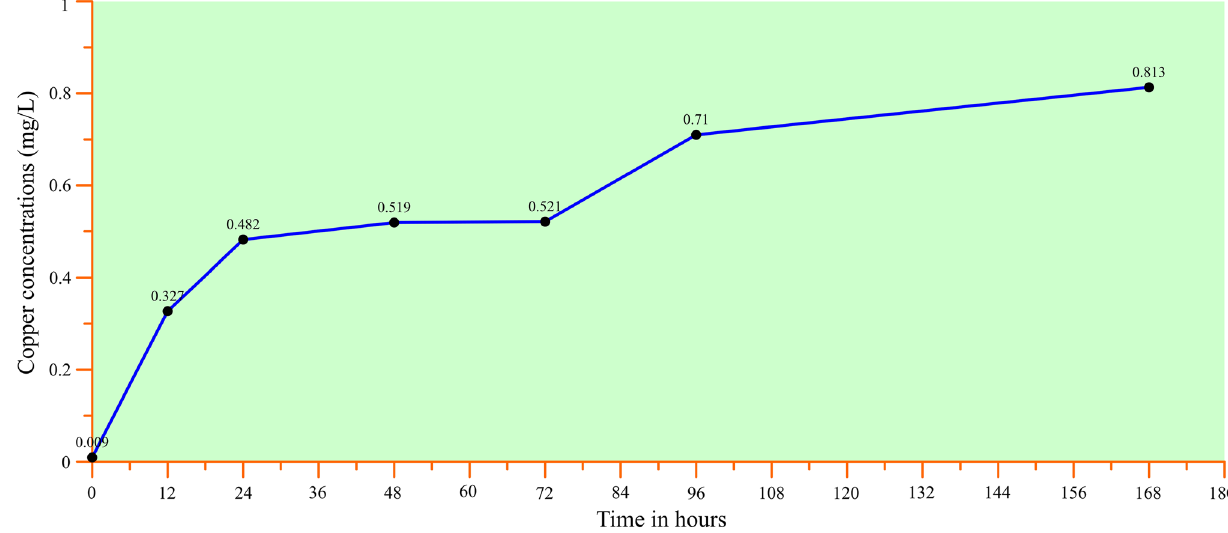
Fig. 4 Plot of copper concentration versus time in